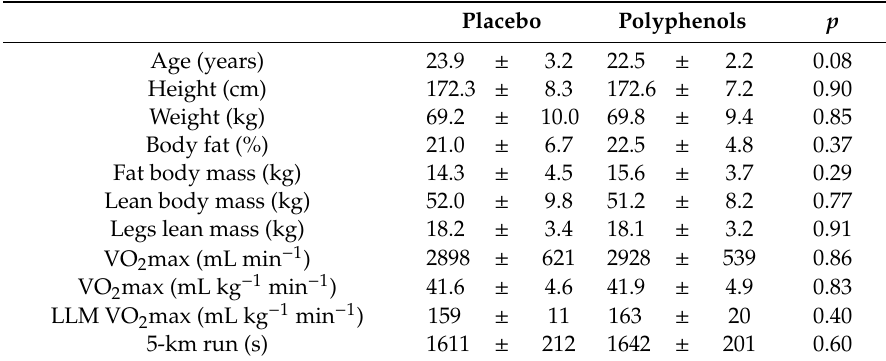
Table 2. Physical characteristics, body composition and VO 2 max by treatment